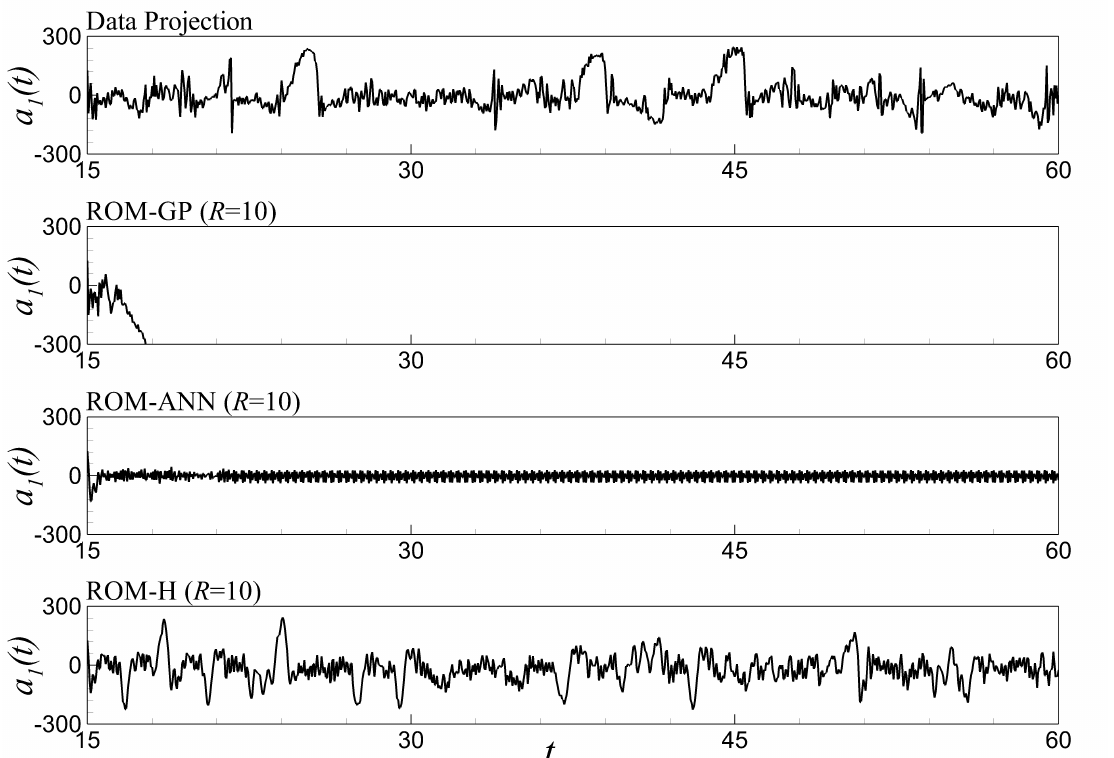
Figure 26. Time series evolution of the first temporal coefficient a 1 ( t ) for the out-of-sample forecast by FOM and different ROM approaches (ROM-GP, ROM-ANN, and ROM-H) using R = 10 POD modes. Predictive performance is shown for Re = 200 while the training has been performed using the data generated at Re = 400.